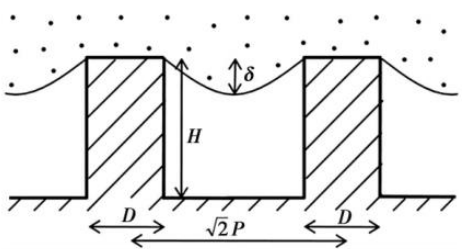
Figure 5. Liquid level and cylinder height of diagonal section of cylindrical structure (Reprinted with permission from Ref. [26]. 2008, Bhushan, B.).